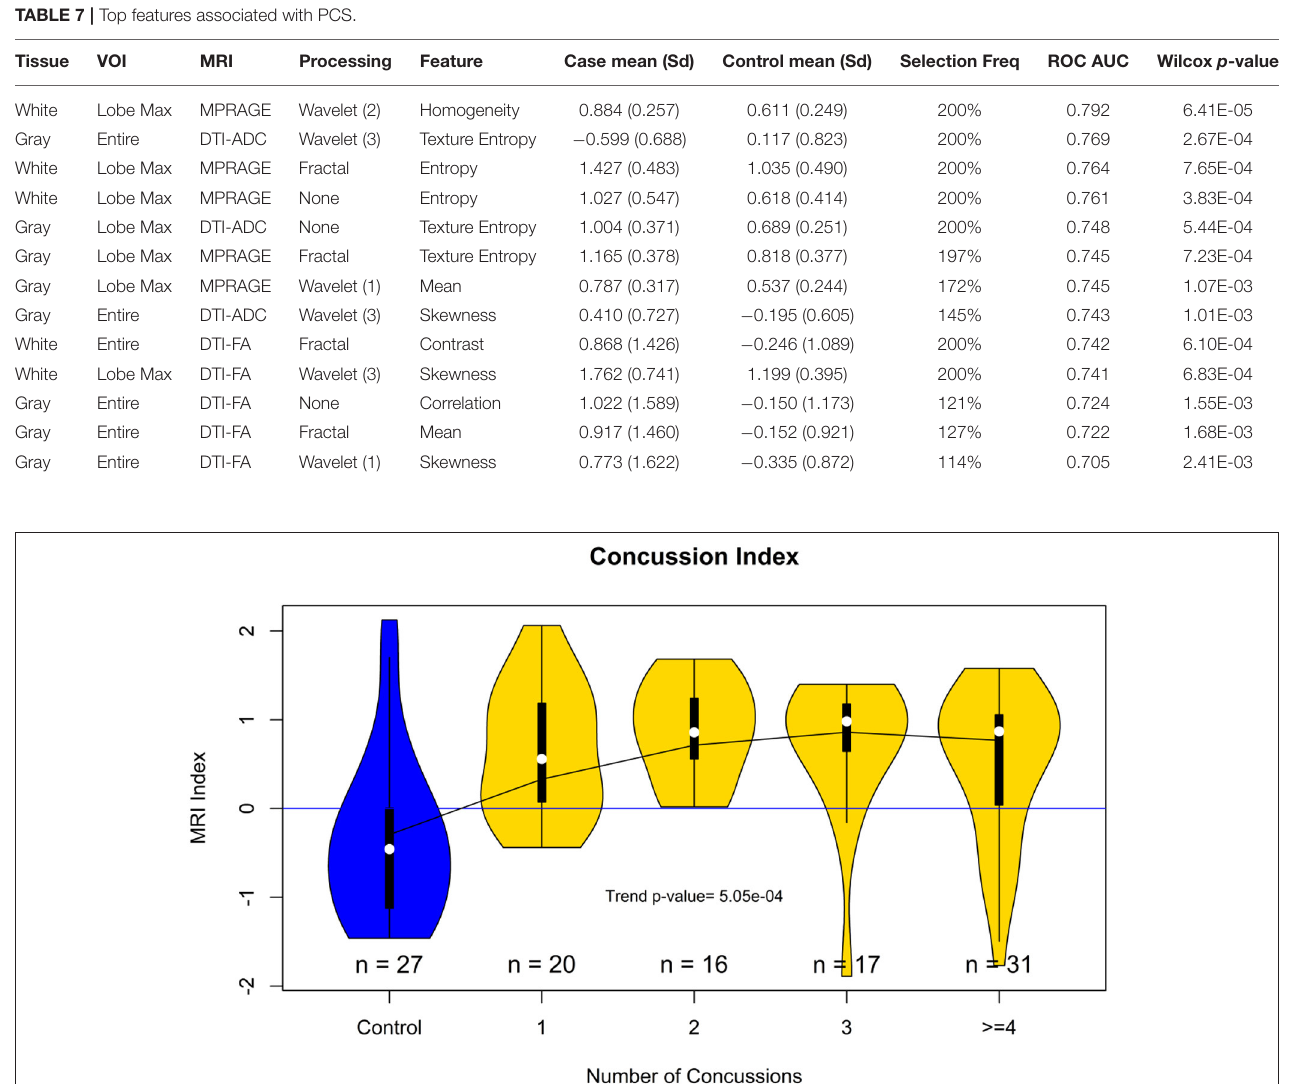
FIGURE 6 | Violin plot showing the distribution of the concussion index stratified by the number of previous concussions. The plot suggests that the accumulated brain trauma plateaus after more than two